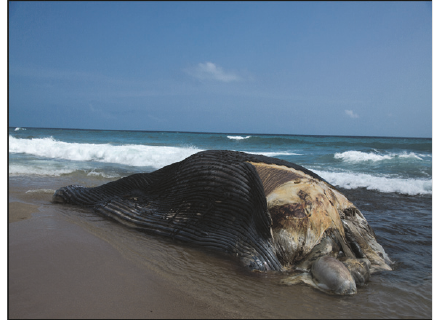
Figure 1: Anterior part of the blue whale.